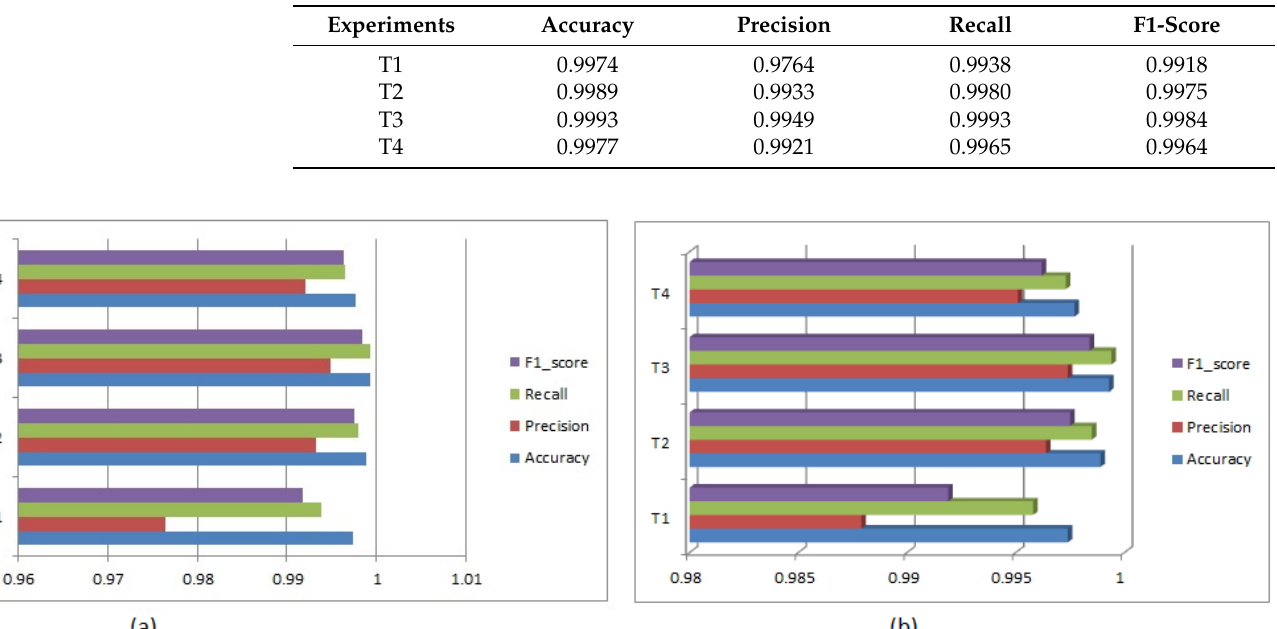
Figure 5. ( a ) Bar graph for the summary of all achieved metrics in all the experiments; ( b ) Bar graph for the summary of all achieved metrics from the confusion matrix in all the experiments. Table 2. A summary of achieved metrics in all the experiments.